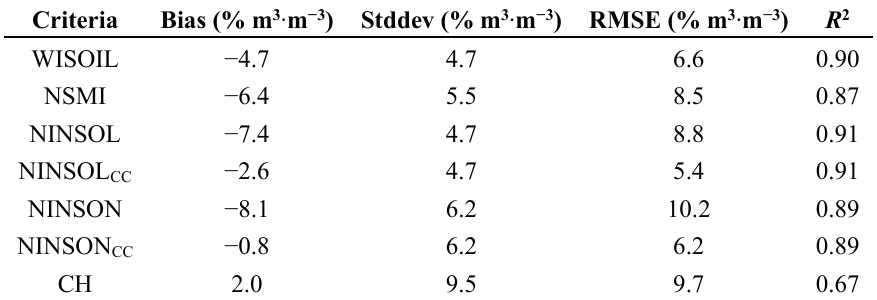
Table 4. Statistical values computed from the comparison of the retrieved soil moisture content (SMC) and the in-situ measured